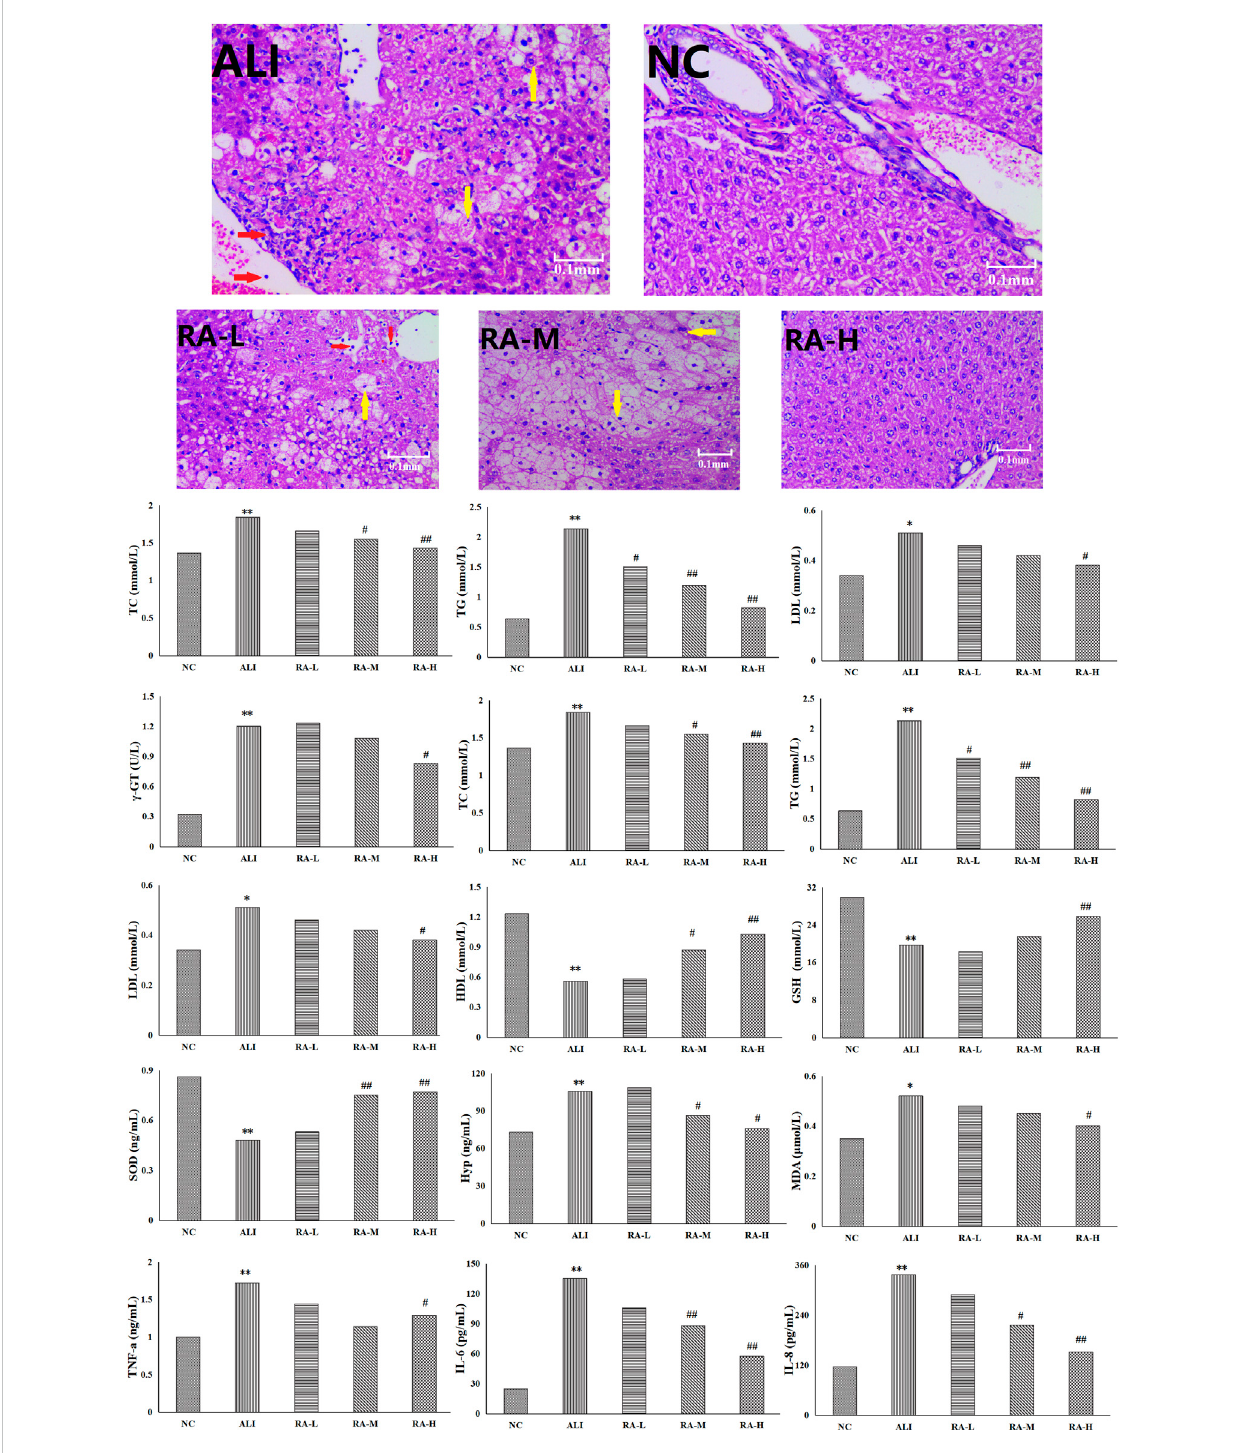
The effects of rhubarb anthraquinone on liver tissue of rats with acute liver injury refers to balloon degeneration and punctate necrosis of hepatocytes; refers to the in fi ltration of lymphocytes and neutrophils.